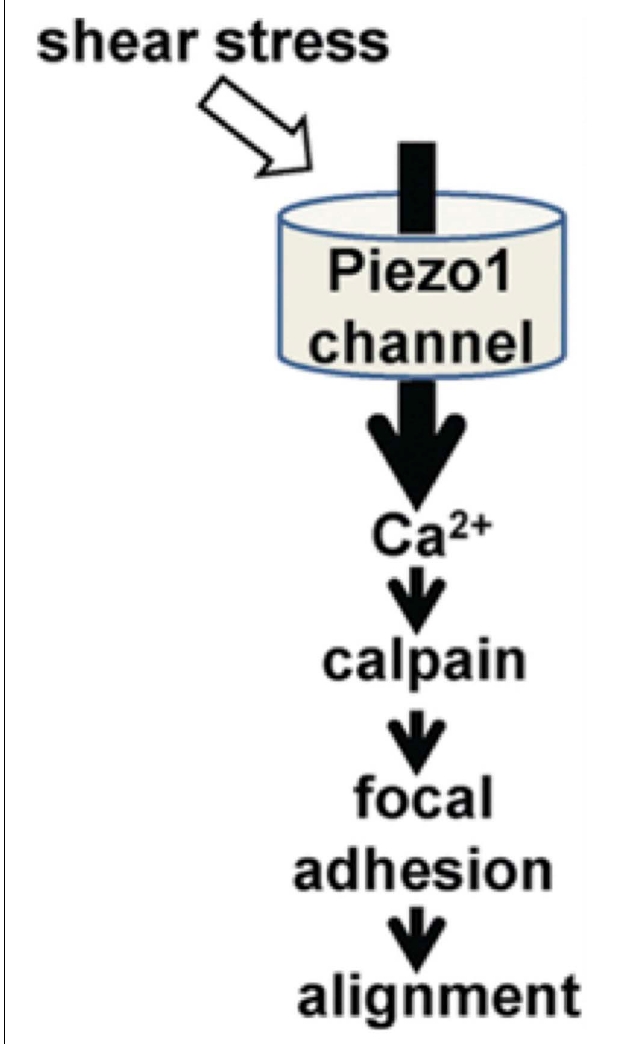
FIGURE 5 | The role of PIEZO1 receptors in alignment of endothelial cells during cardiovascular embryological development (Li et al., 2014).